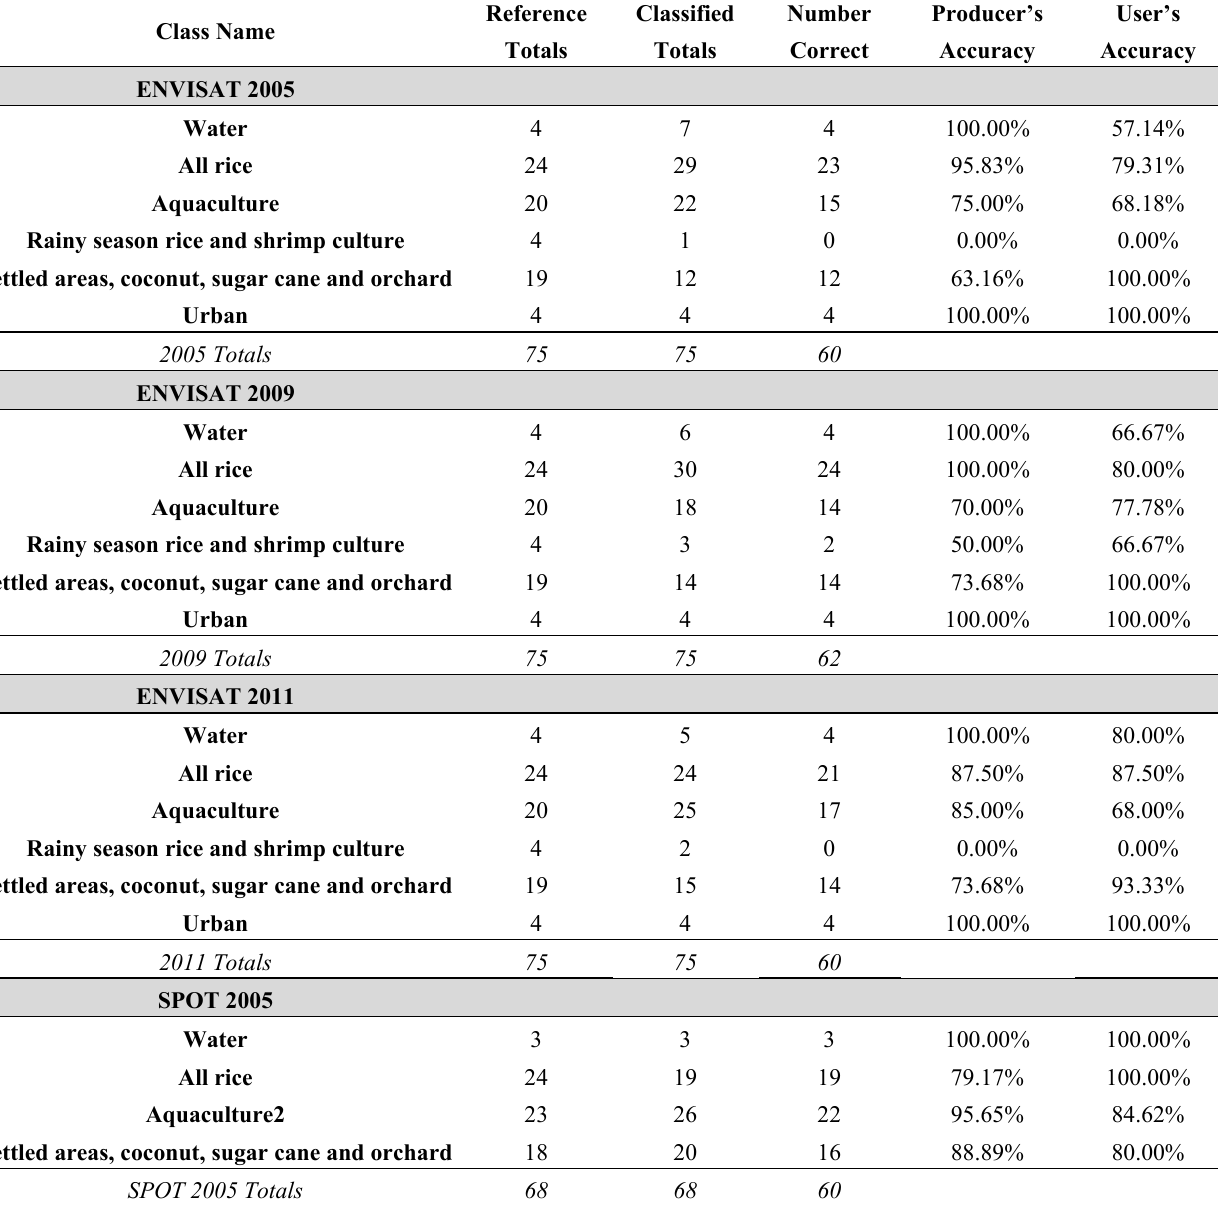
Table 6. Accuracy of the